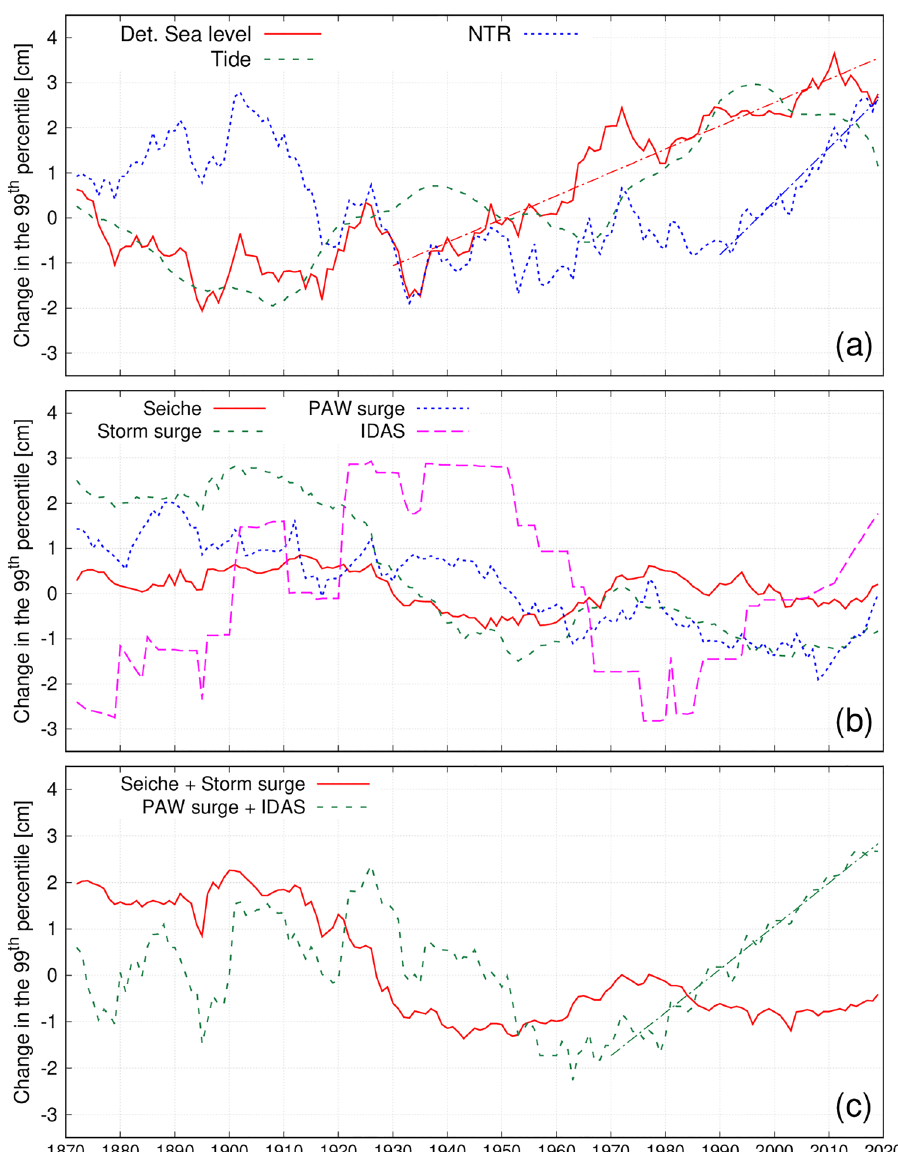
Figure 3. Temporal changes of the 99th percentiles of the different drivers, computed with respect to the long- term mean value. The dash-dotted lines indicate the trends discussed in the text (slope statistically significant at the 0.05